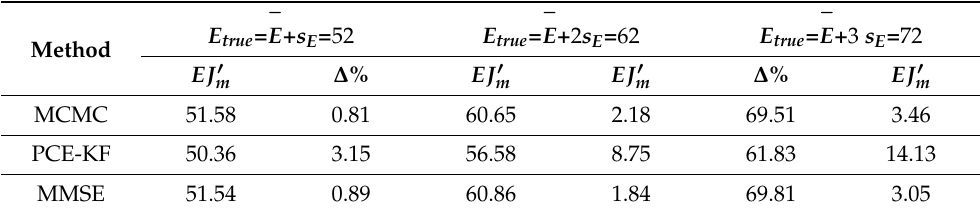
Table 10. Comparison of posterior mode E (cid:48) m and E true according to different updating procedures by measuring the displacement in two different points.